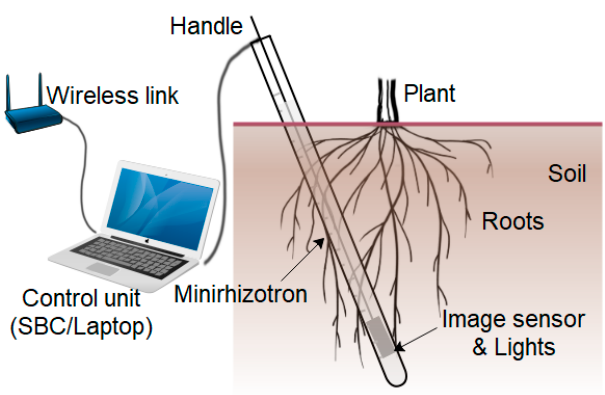
Figure 1. Field operation of a common minirhizotron with a wireless interface as advancement.